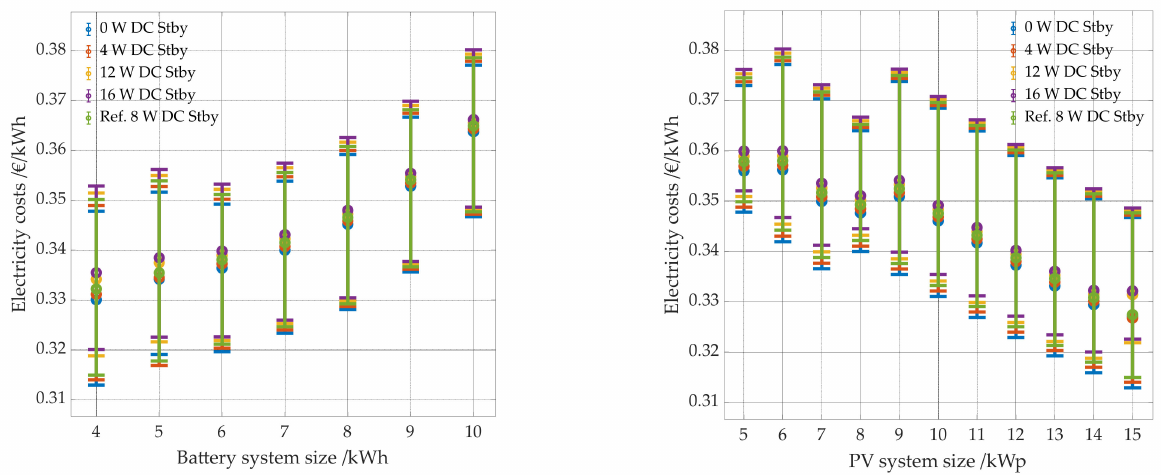
Figure 21. Electricity costs per kWh as a function of battery system size ( left panel) and PV system size ( right panel). The results for different levels of DC standby consumption are shown in color. The reference case with an DC standby consumption of 8 W is shown in green.